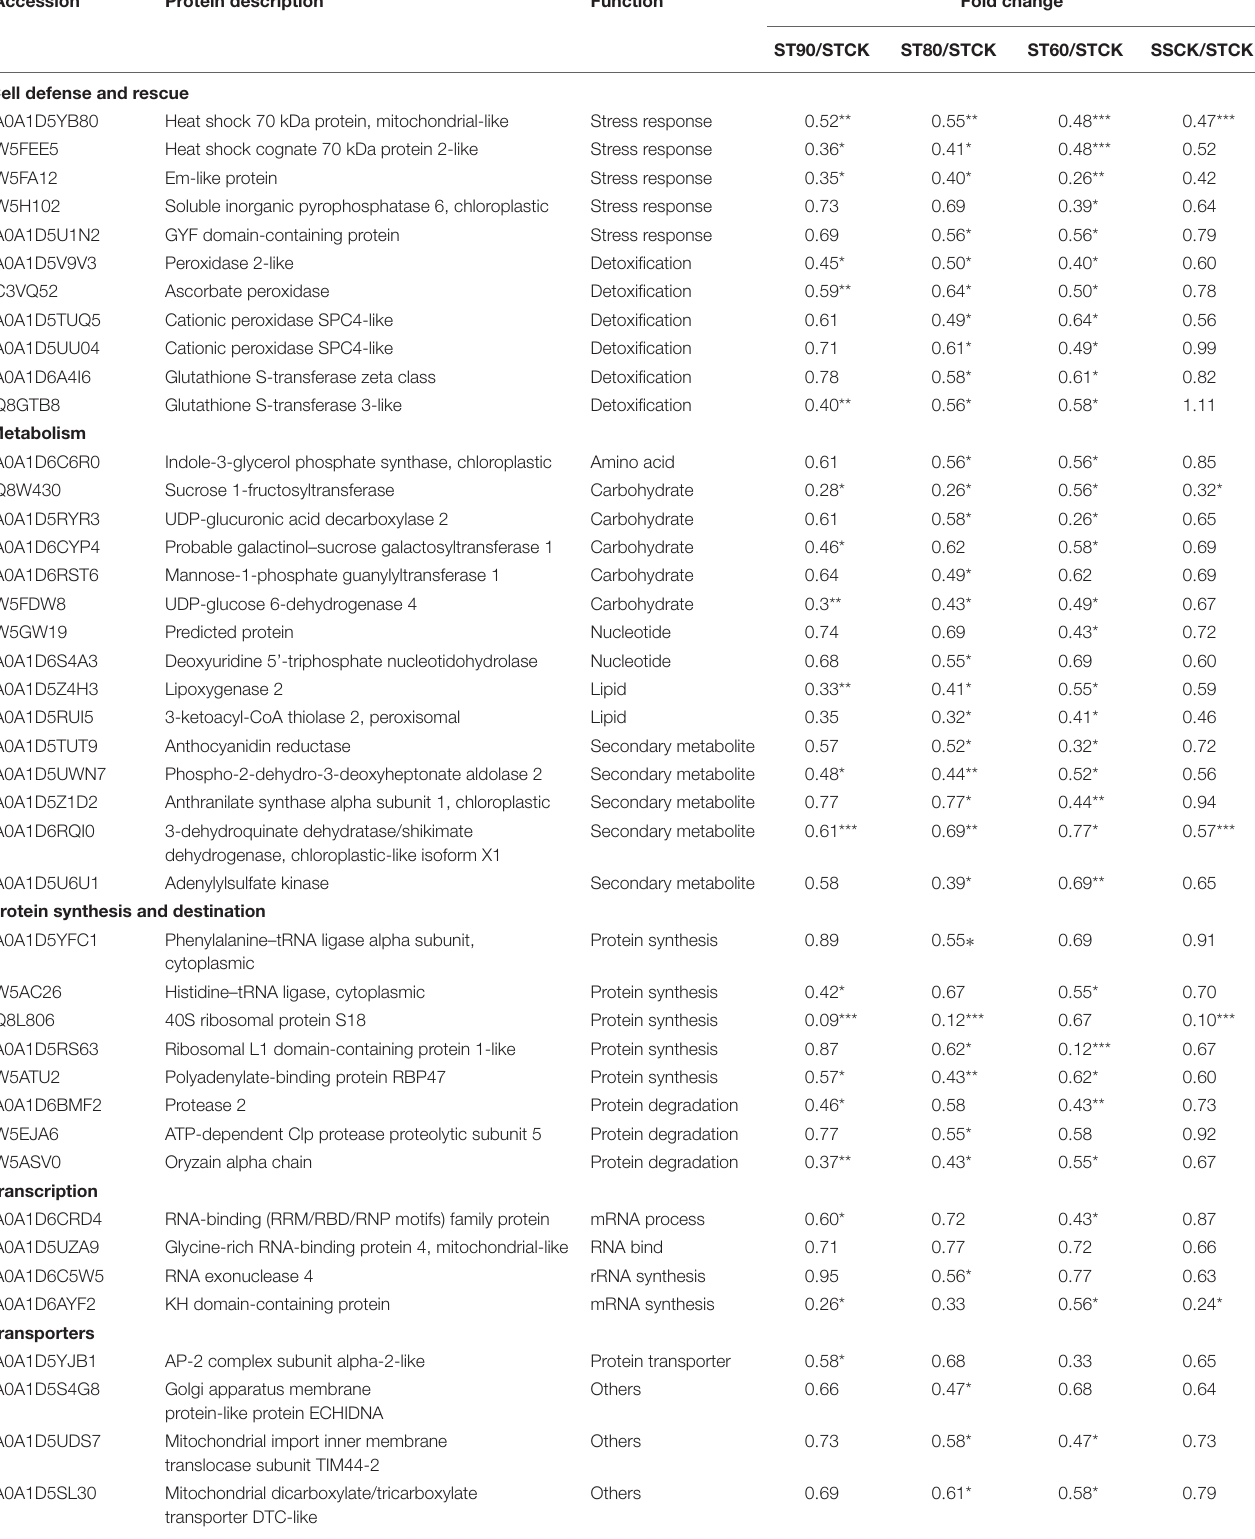
TABLE 2 | Differentially abundant proteins in embryos of ST seeds with significant trend in down-regulation during artificial aging at 40 ◦ C and 75% relative humidity. Accession Protein description